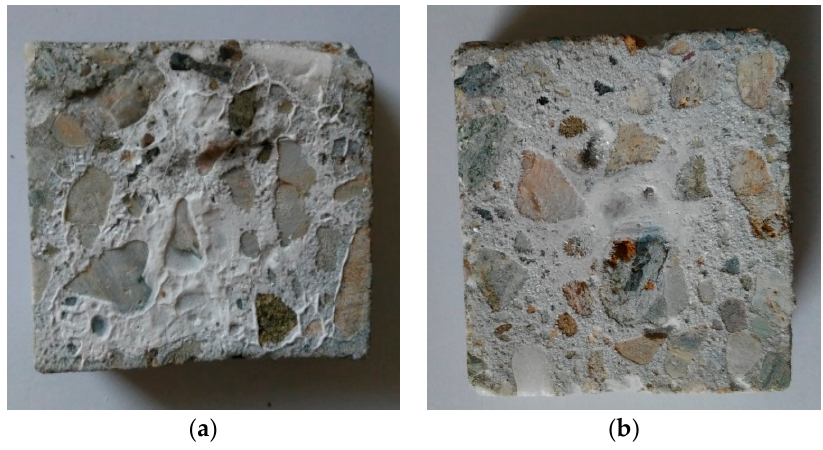
Figure 8. Samples ( a ) without and ( b ) with the addition of silica fume after the bacterial exposure.